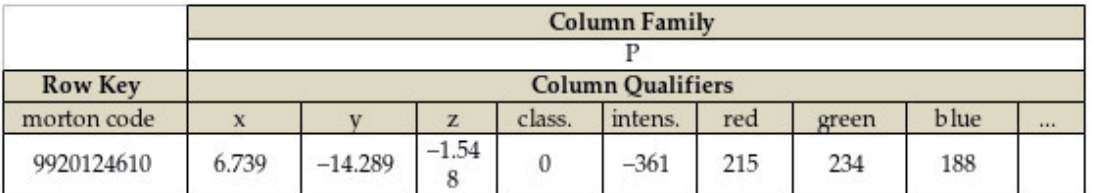
Figure 4. Structure of the point record with Morton code.